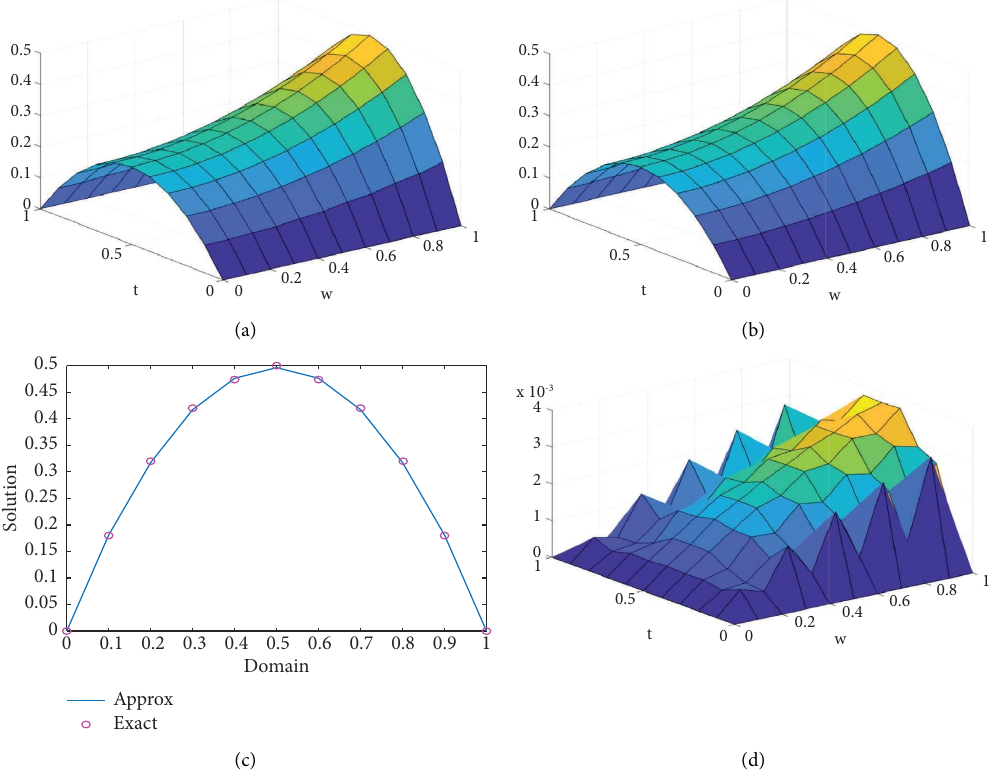
Figure 2: Graphical solution of approximate, exact, and error of Y at h � Δ t � 0 . 1 and plot at t � 1. (a) Approximate solution. (b) Exact solution. (c) Approximate vs Exact. (d)